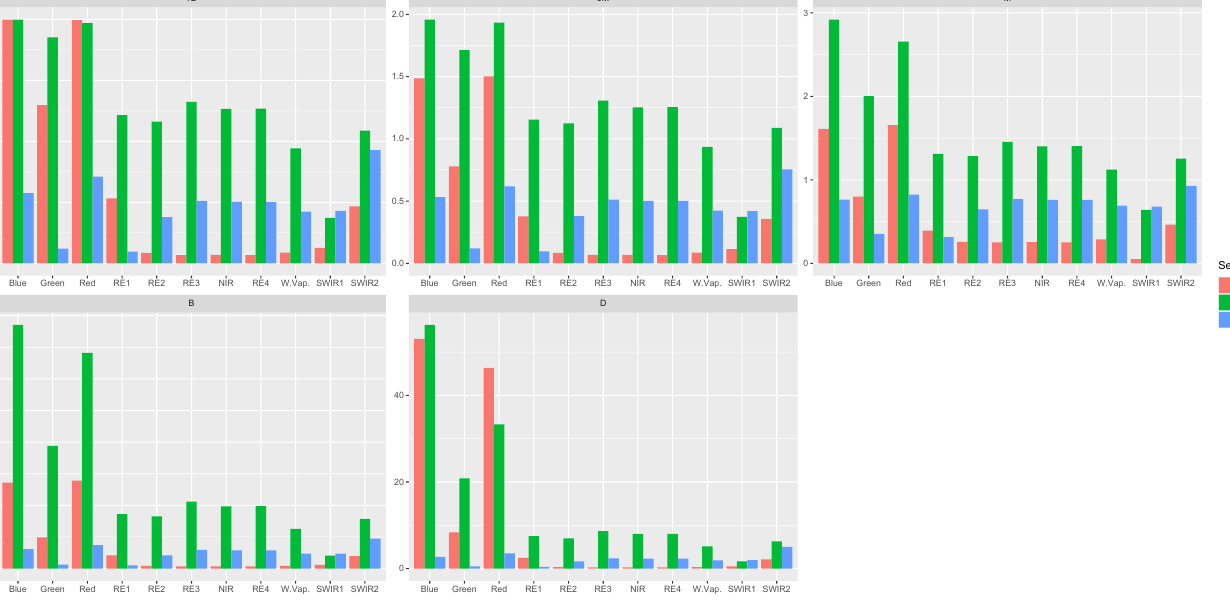
Figure 6. Seasonal spectral separability metric results between western snowberry and wolfwillow across selected Sentinel- 2A bands (Transformed Divergence (TD), Jeffries–Matusita (JM) distance, M-Statistic (M), Bhattacharyya distance (B), Divergence